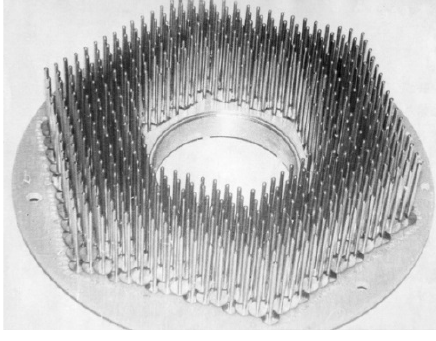
Fig. 7. Photograph of a multirod electrostatic